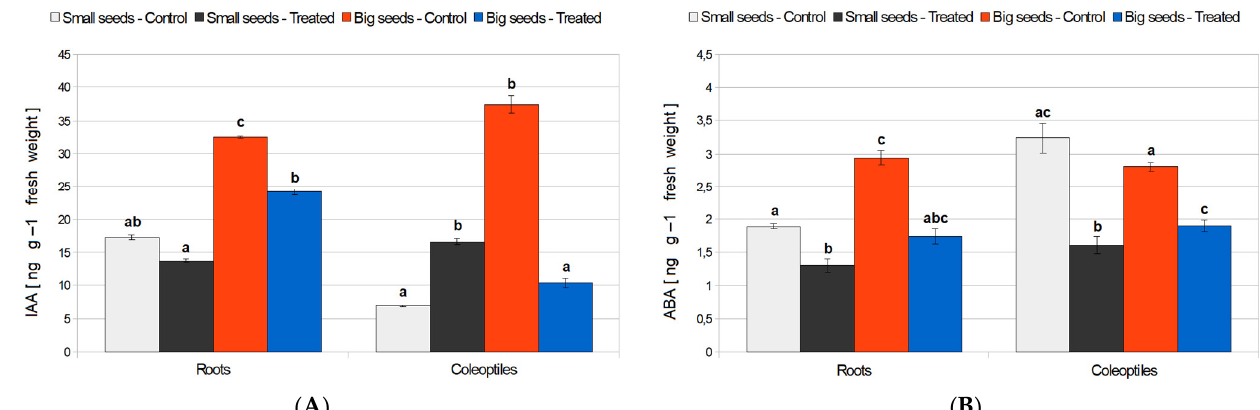
Figure 6. Determination of endogenous levels of ( A ) IAA and ( B ) ABA phytohormones in 3-day-old roots and shoots (coleoptiles) growing in darkness from small and big seeds of winter wheat under control and treatment conditions. Data are shown as mean values ( n = 3), and bars represent standard error ± SE. Different letters above the bars indicate significant differences at p < 0.05 (two-tailed t -test).